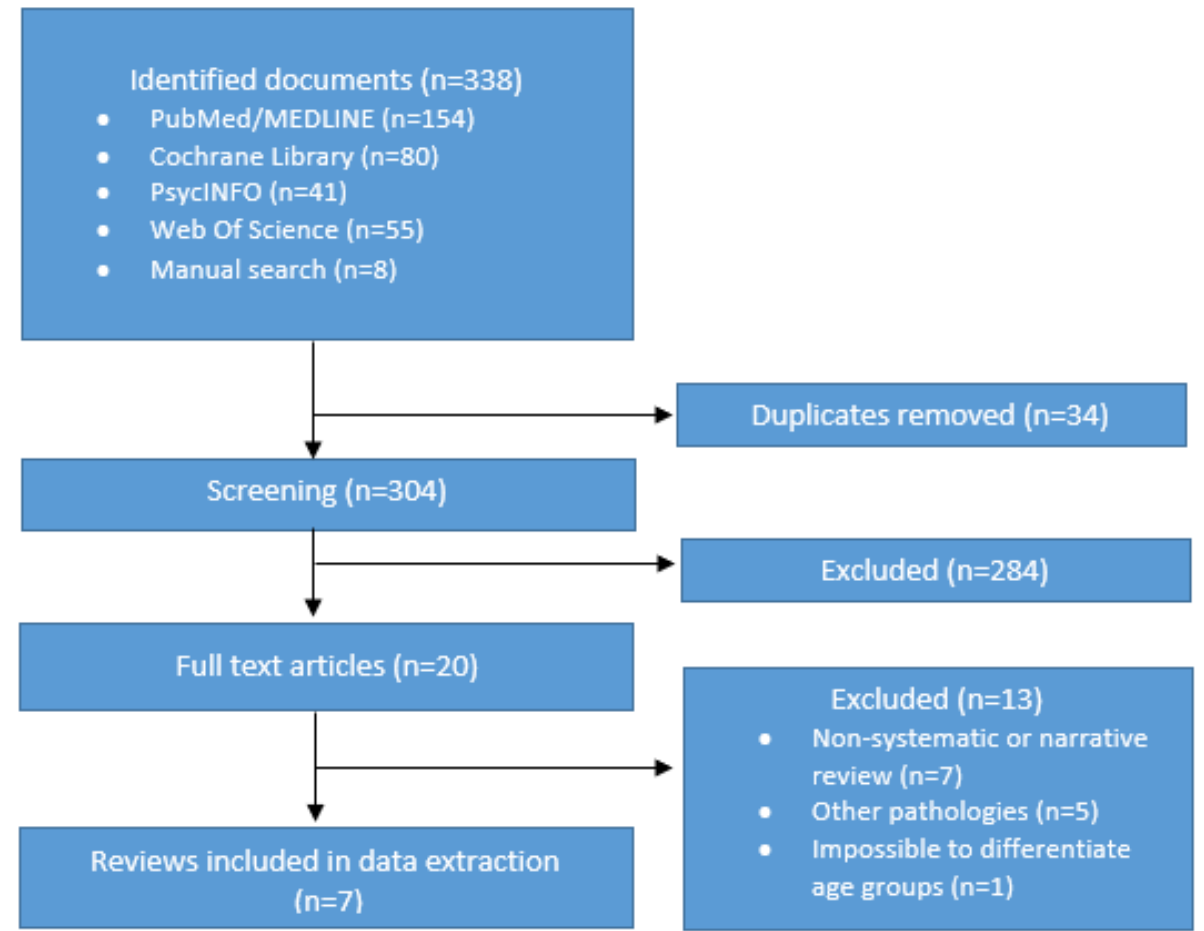
Figure 1. Flow diagram of the review